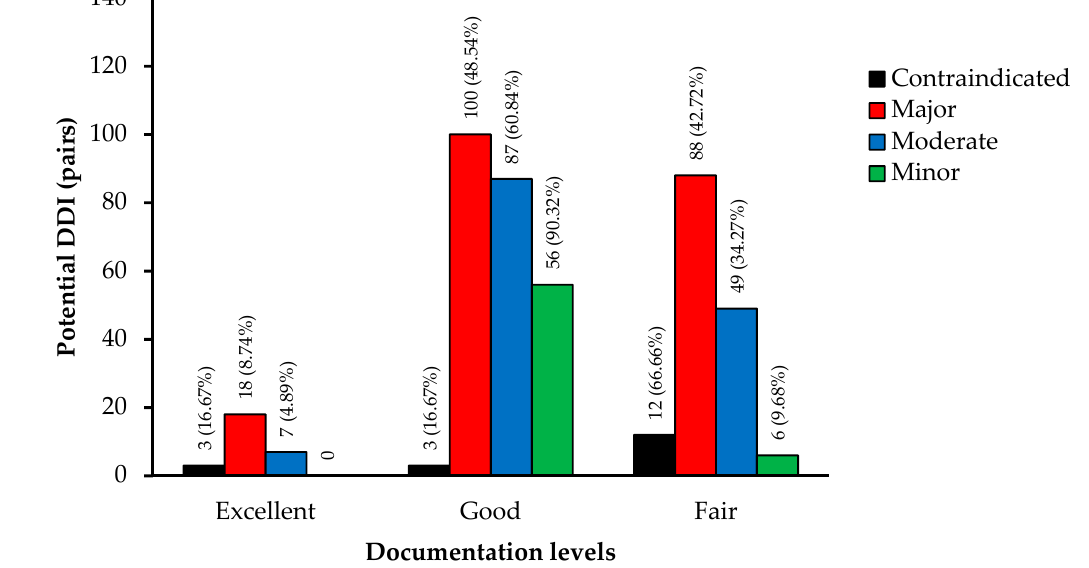
Figure 3. Result of the potential DDIs at each documentation level of Micromedex.